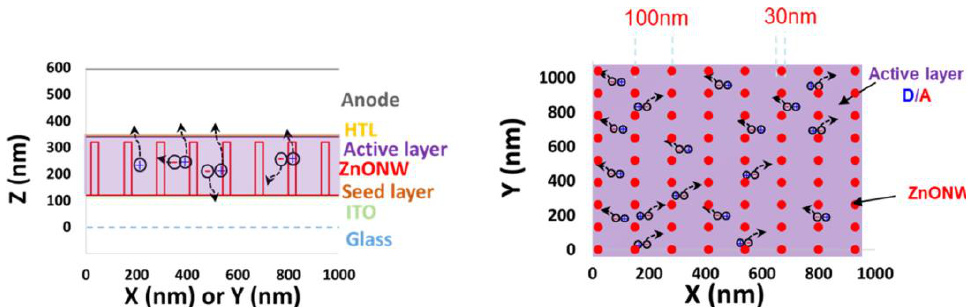
Figure 4. Morphological characteristics and dimensions of an ideal network of ZnO nanowires (ZnONW) for optimal solar cell assembly: ZnONW length ~200 nm, ZnONW diameter ~30 nm, ZnONW spacing ~100 nm ( left ) and cross-section, XY plan ( right ): HTL — hole transport layer; ITO — oxide layer consisting of a mixture of 90 wt% indium oxide In 2 O 3 and 10 wt% tin oxide SnO 2 [79].